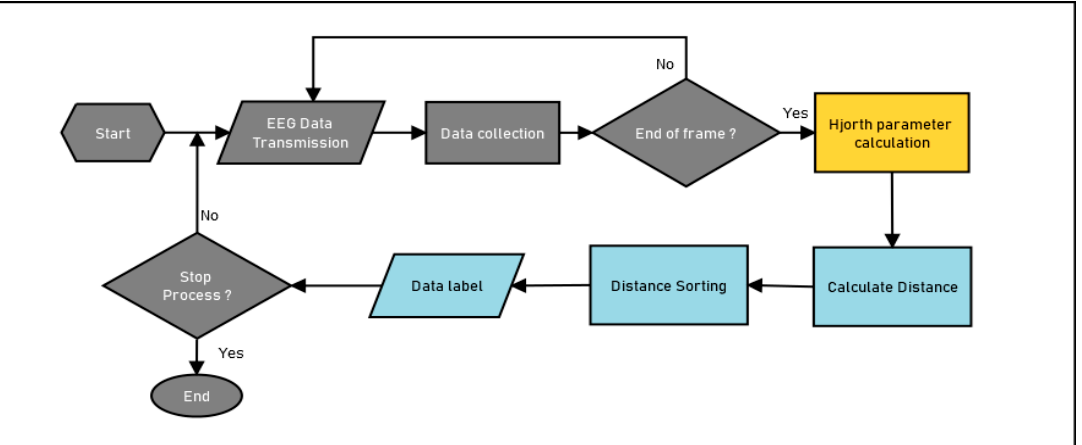
Figure 1 . The complete system flowchart for the proposed real-time epileptic EEG classification .